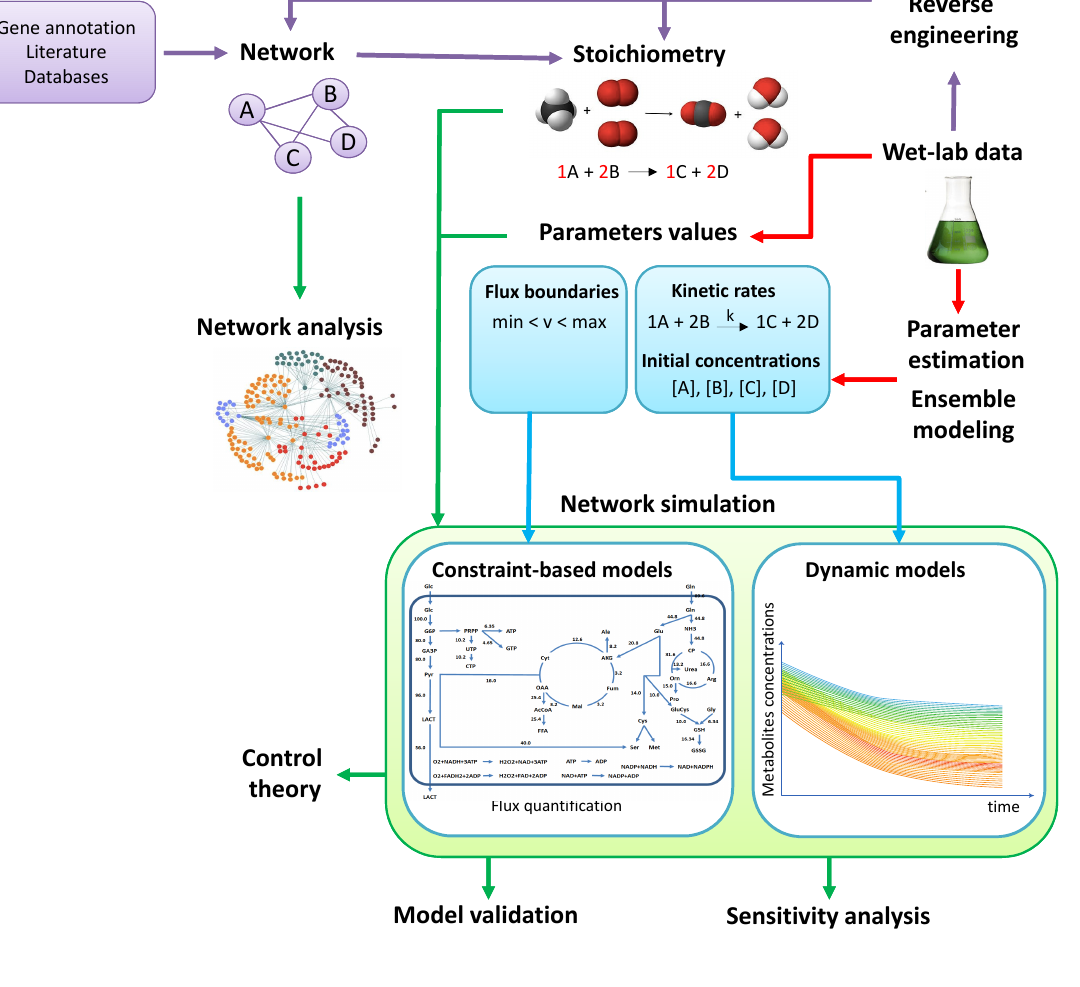
Figure 2. General scheme of the computational investigation of metabolism, from network reconstruction to in silico analysis. Violet arrows indicate the relationships between experimental data and reverse engineering methods used to reconstruct the metabolic network and to identify the stoichiometry of the reactions (see Sections 2.1 and 2.3) Red arrows indicate the relationships between experimental data and the methods to derive or estimate the unknown parameters (see Sections 2.2 and 2.4). Green arrows indicate the computational analyses that can be performed on metabolic networks and models (see Sections 3 and 4). Blue arrows indicate specific computational analyses that can be carried out on different types of models (see, in particular, Sections 3.2 and 3.3).